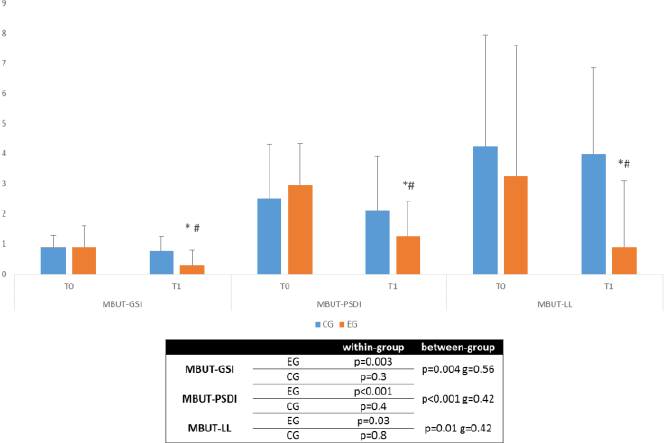
Figure 2. Primary outcome measures (median + interquartile range). * significant within-group dif- ferences, # significant between-group differences. Legend: EG, experimental group; CG, control group; T0, evaluation at baseline; T1, evaluation at the end of the protocol; MBUT, Modified Body Uneasiness Test; GSI, General Severity Index; PSDI, Positive Symptom Distress Index; LL, lower limbs; g, Hedges’ g standardized mean difference. Table 2. Statistical comparison of changes in the clinical score of a primary outcome measure of